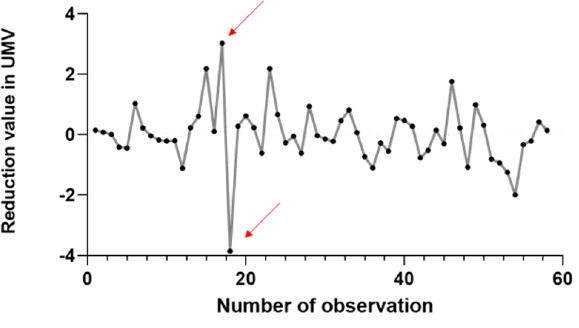
Figure 8. Pattern found in UMV for real data.